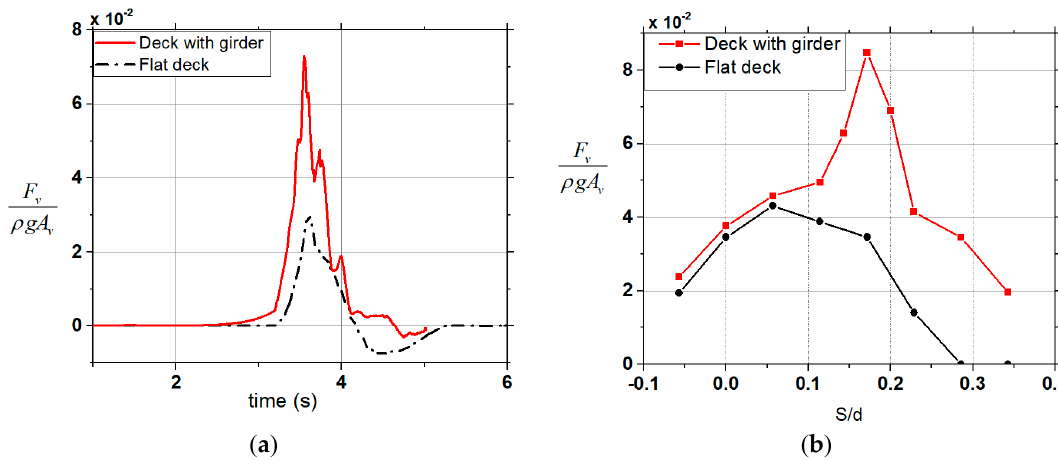
Figure 6. ( a ) Comparison of force-time history of a flat deck and deck with girders due to solitary wave (H = 0.2d) impact at an airgap, S/d = 0.17. ( b ) Comparison of vertical impact force for a deck with and without girders for a varying S/d ratio.